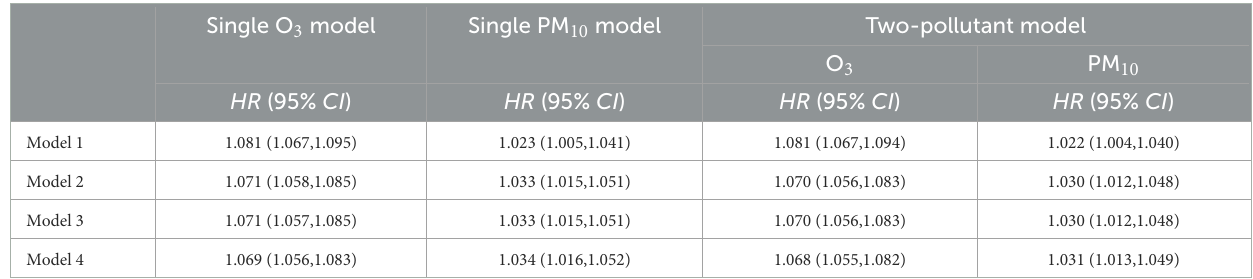
TABLE 2 Association between air pollution and all-cause hospitalization risk.